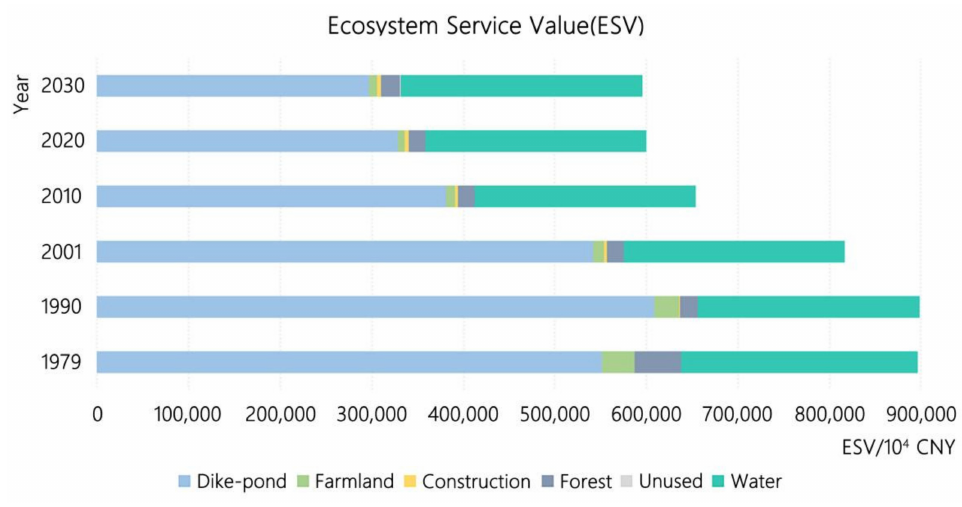
Figure 7. Landscape index changes in the study area at the landscape scale from 1979 to 2030.